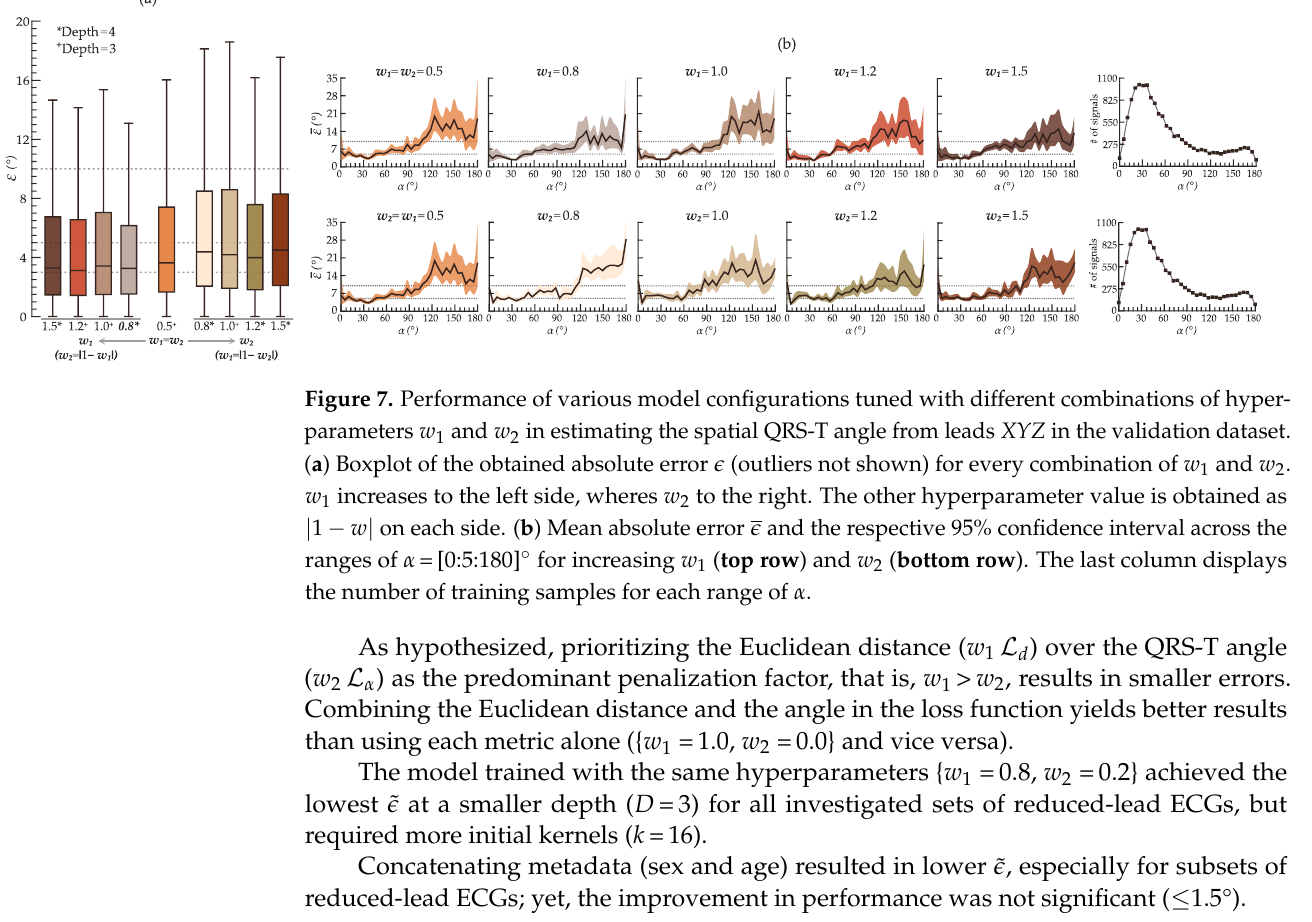
Table 1. Performance deep-learning-based estimation of the spatial QRS-T angle α from various sets of leads in whole the validation dataset, and in ECGs with healthy and diseased cardiac function. Subset of Leads